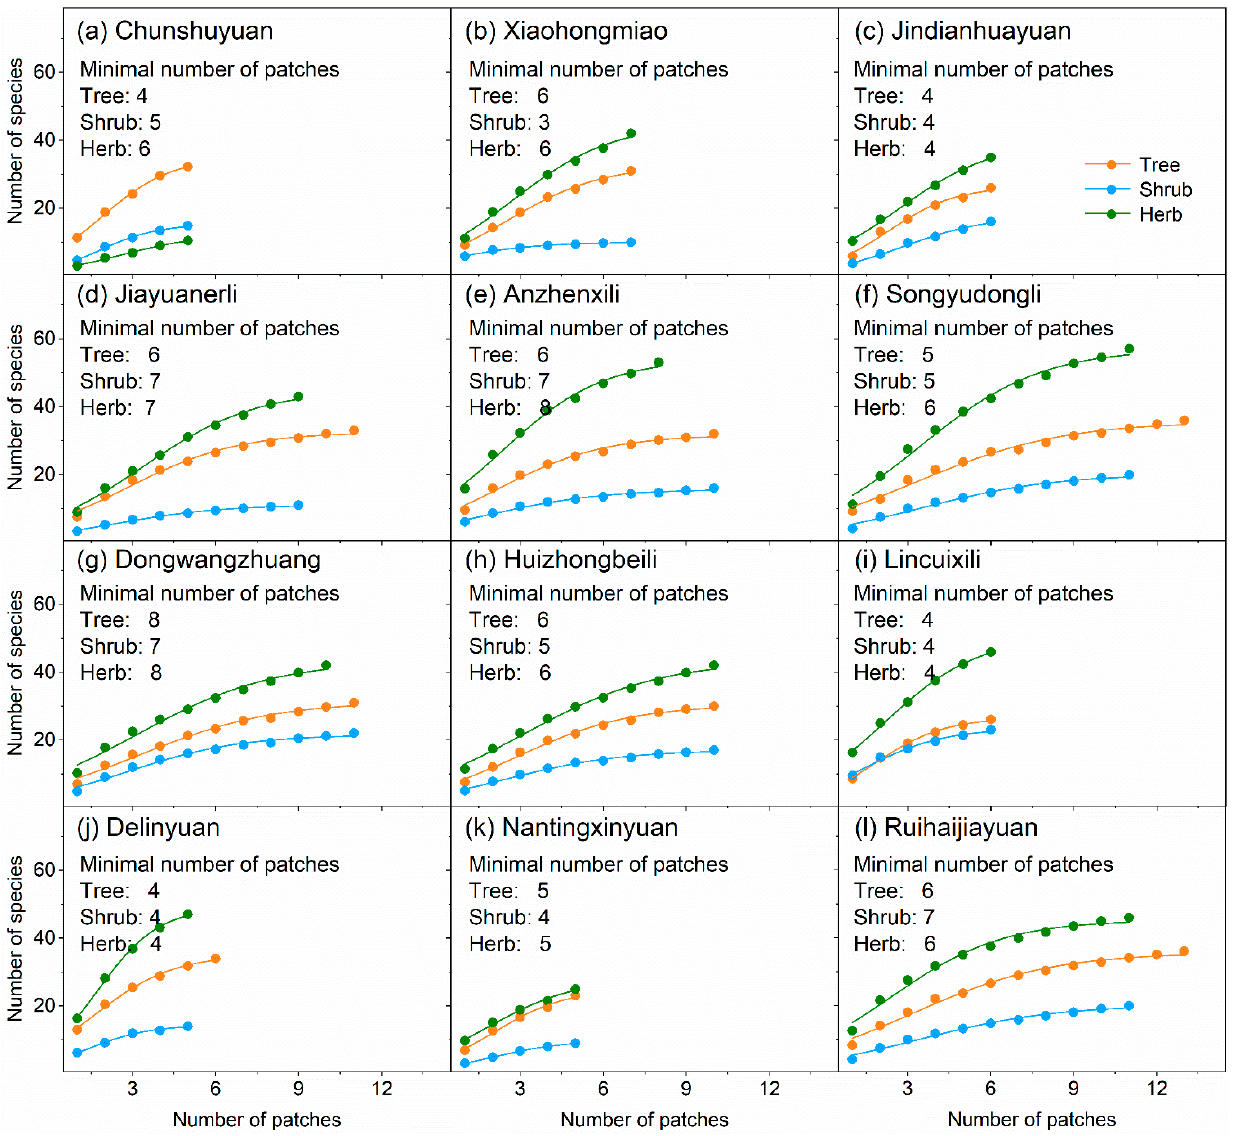
Figure 4. Number of species-number of patches accumulation curves based on logistic function. Adjusted R 2 for all curves was more than 0.98. F value for all curves was extremely significant.